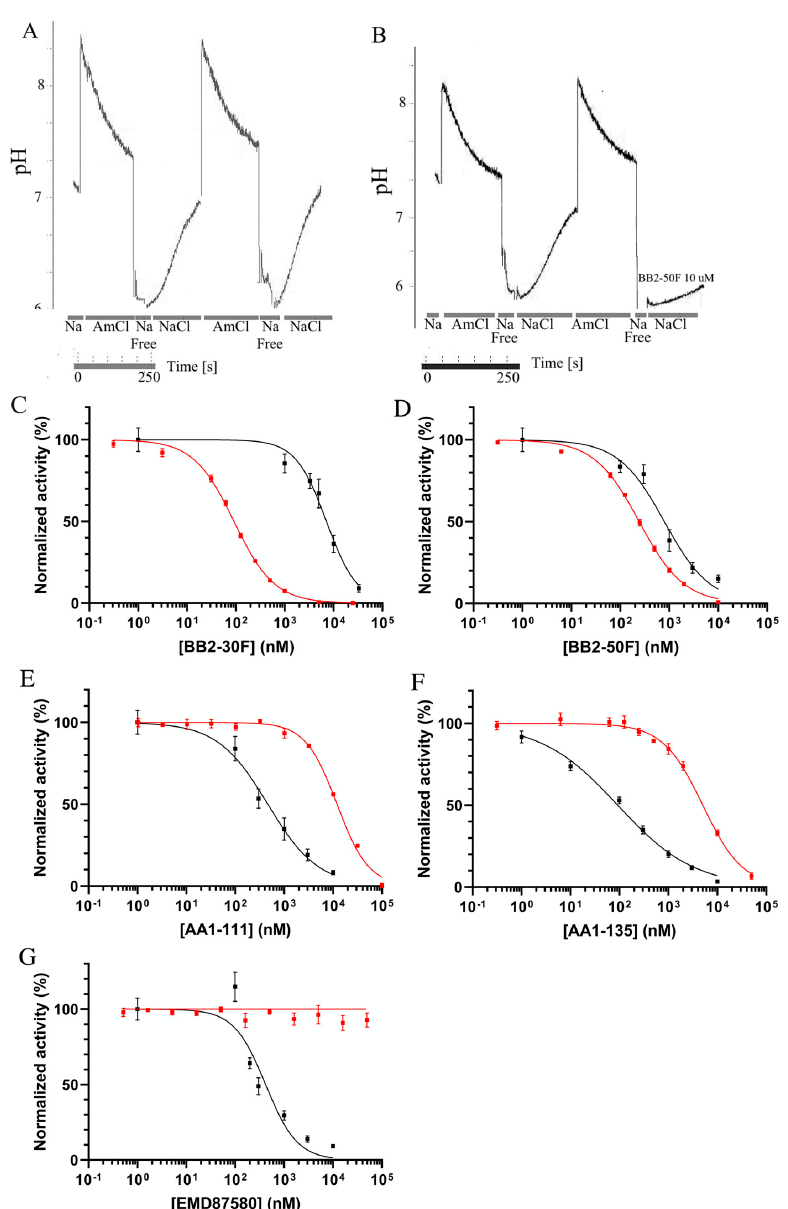
no inhibitory activity towards uPA; however, other compounds displayed varying potencies, with AA1-135 and AA1-111 displaying lower potency, and BB2-30F and BB2-50F showing much higher potency, consistent with previous reports [32] (Table 1).